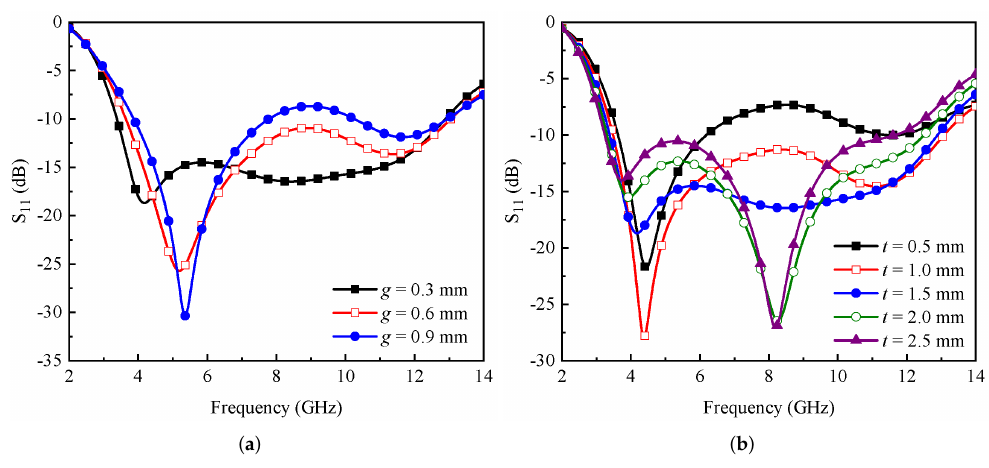
Figure 6. Effect of parameter ( a ) g and ( b ) t on the antenna’s performance.